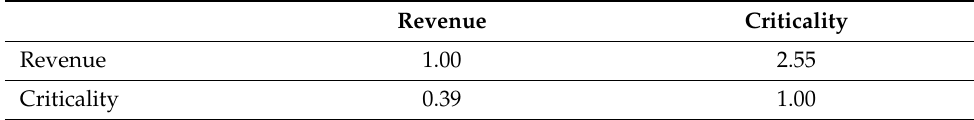
Table 2. Objectives judgment matrix.